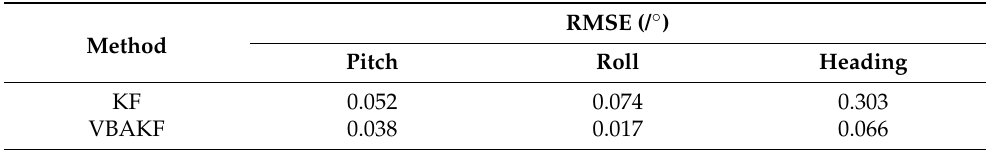
Table 2. The RMSE result of the three-dimensional attitude estimation errors when the measured